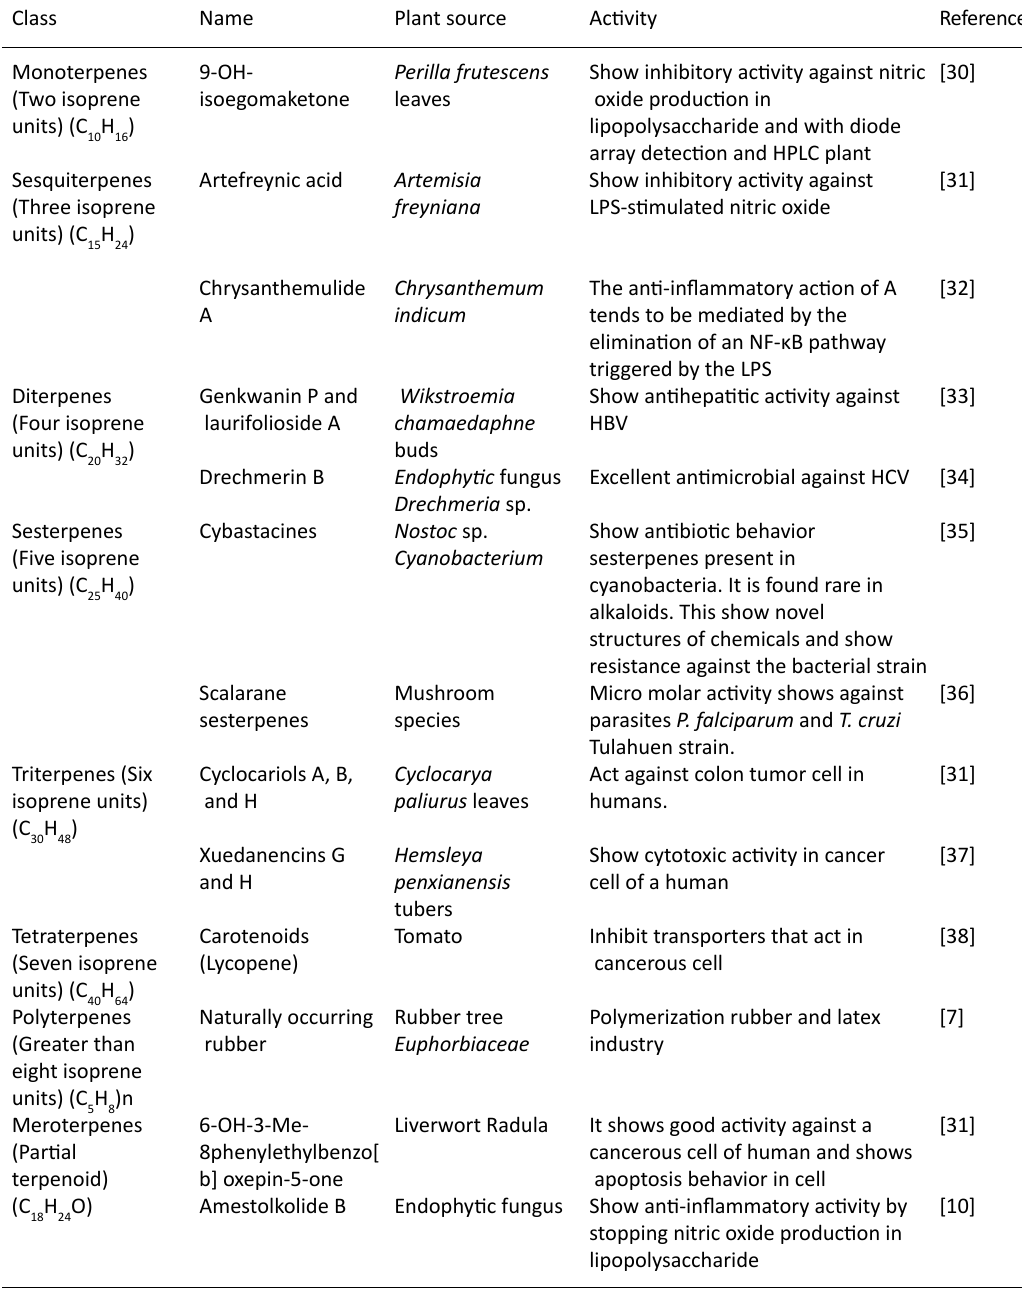
Table 2. Classification of terpenoids based on the number of carbon units and their activities as reported by recent